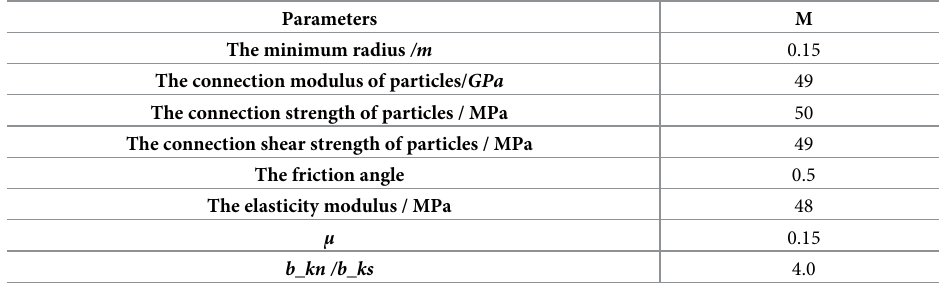
Table 2. Parameters of the rock sample.